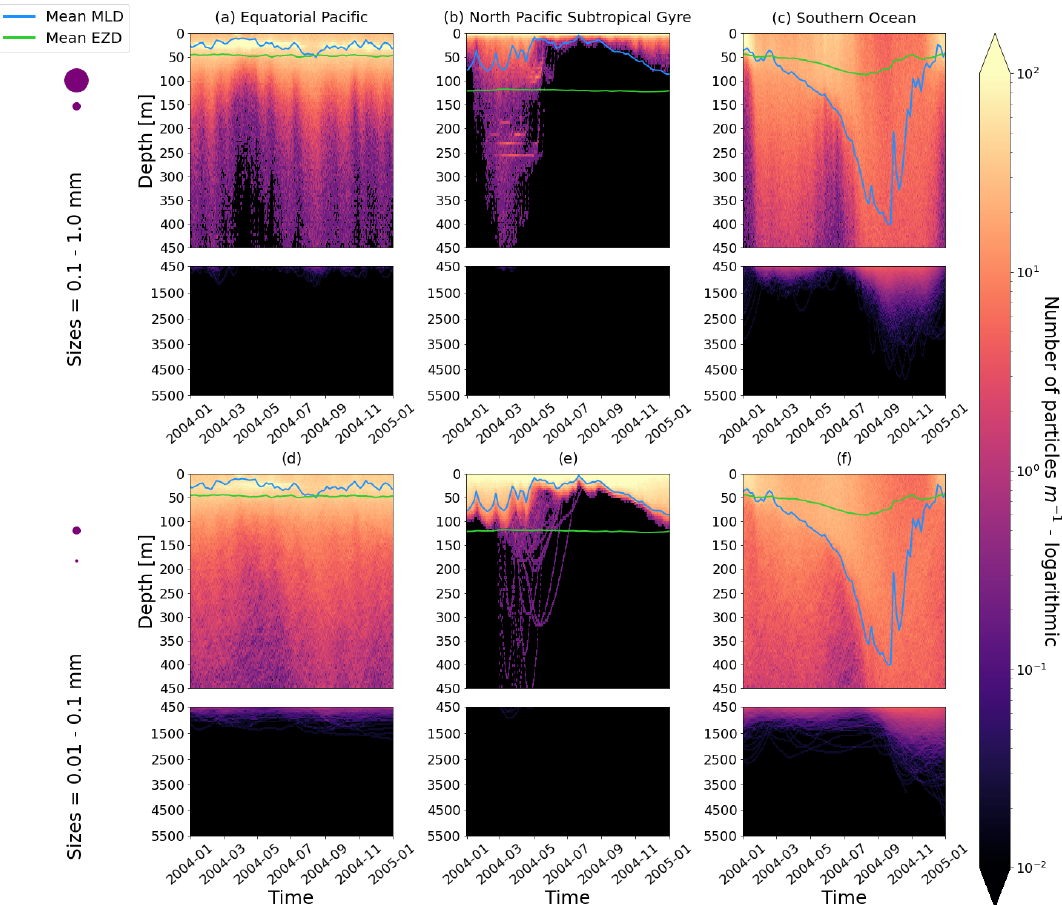
Figure 2. The vertical particle distribution of 10000 particles over 1 year (after a 3-month model spin-up) for two size classes in three locations. The largest particles have a radius of 0.1 to 1.0mm (top row; subplots a , b , c ), and the smallest particles have a radius of 0.01 to 0.1mm (bottom row; subplots d , e , f ). The three locations are the equatorial Pacific (EqPac; left column), North Pacific Subtropical Gyre (NPSG; middle column) and Southern Ocean (SO; right column). Each subplot is divided into two panels with the top panel from 0 to 450m and the bottom panel from 450 to 5500m. The horizontally averaged mixed-layer depth (MLD; blue line) and euphotic-zone depth (EZD; green line) are also displayed. Note that to isolate the effects of vertical physical characteristics and regional biological processes, horizontal advection is omitted from these simulations. The colour bar represents a logarithmic number of particles per metre (the total number of particles being 10000), where light yellow denotes all values of 100 particles or more. Please note that the date format used in this and following figures is